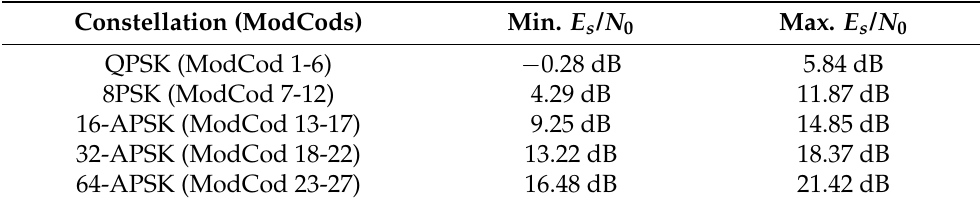
Table 1. Minimum operative E s / N 0 ranges extracted from [17] for timing